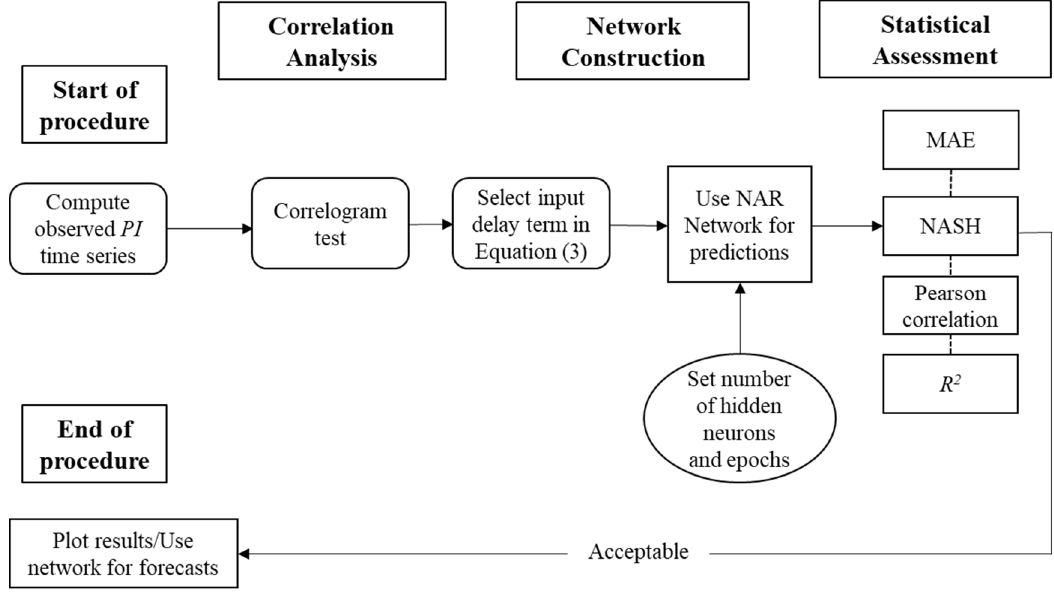
Figure 4. Flowchart illustrating the computational procedures for drought forecasting. MAE: mean absolute error, NASH: Nash–Sutcliffe coefficient.